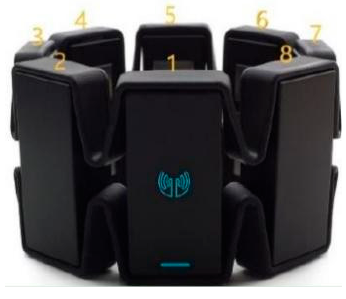
Figure 1. Myo armband.